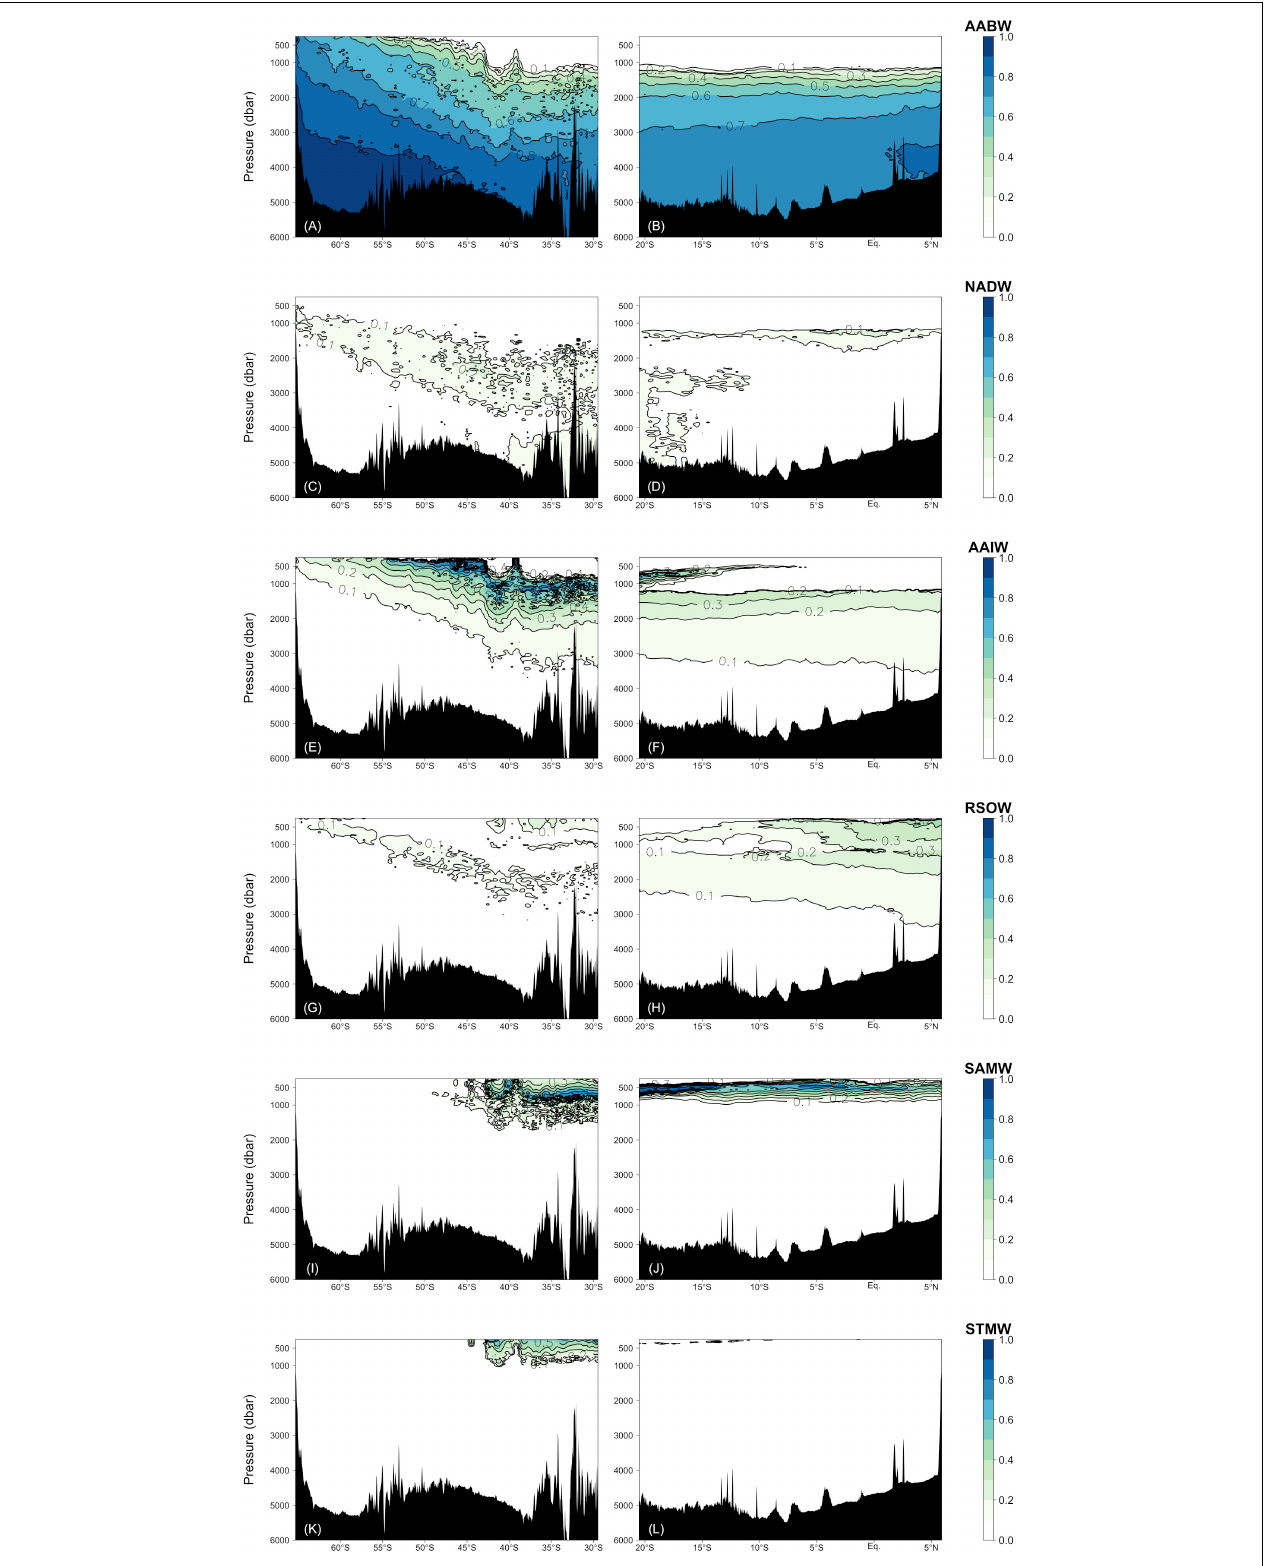
FIGURE 4 | Fractions of the water masses confirmed by the water mass analyses: (A,B) AABW = WSW + ALBW, (C,D) NADW, (E,F) AAIW, (G,H) RSOW, (I,J) SAMW, and (K,L) STMW. Right and left columns represent the Leg 2 and Leg 3 transects, respectively.